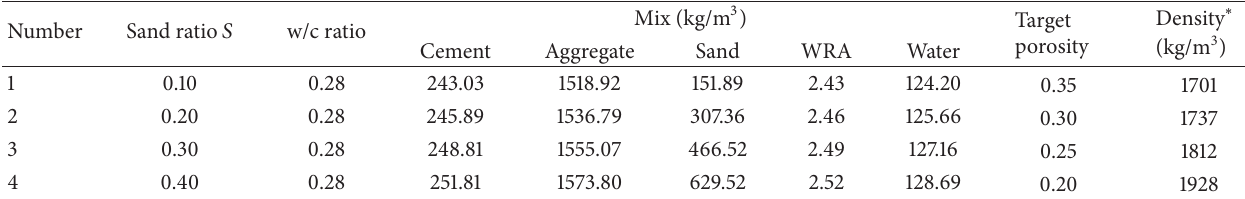
Table 1: Mix proportion.